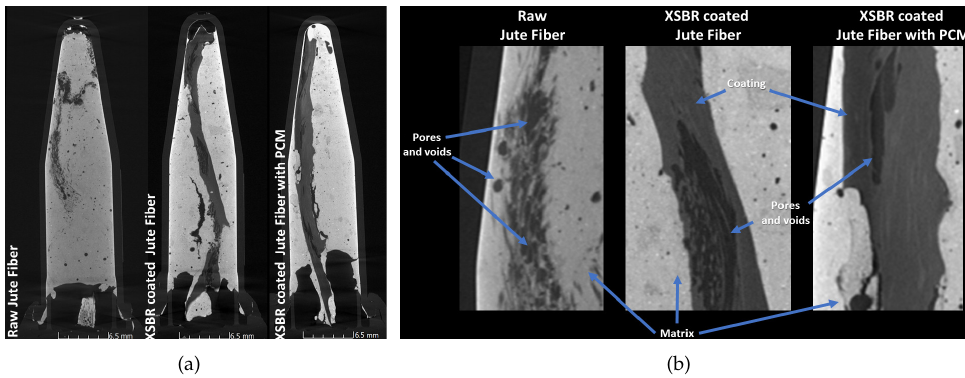
Figure 8. CT scan images of jute yarns embedded in cement: microcentrifuge tubes ( a ); pores and voids detail ( b